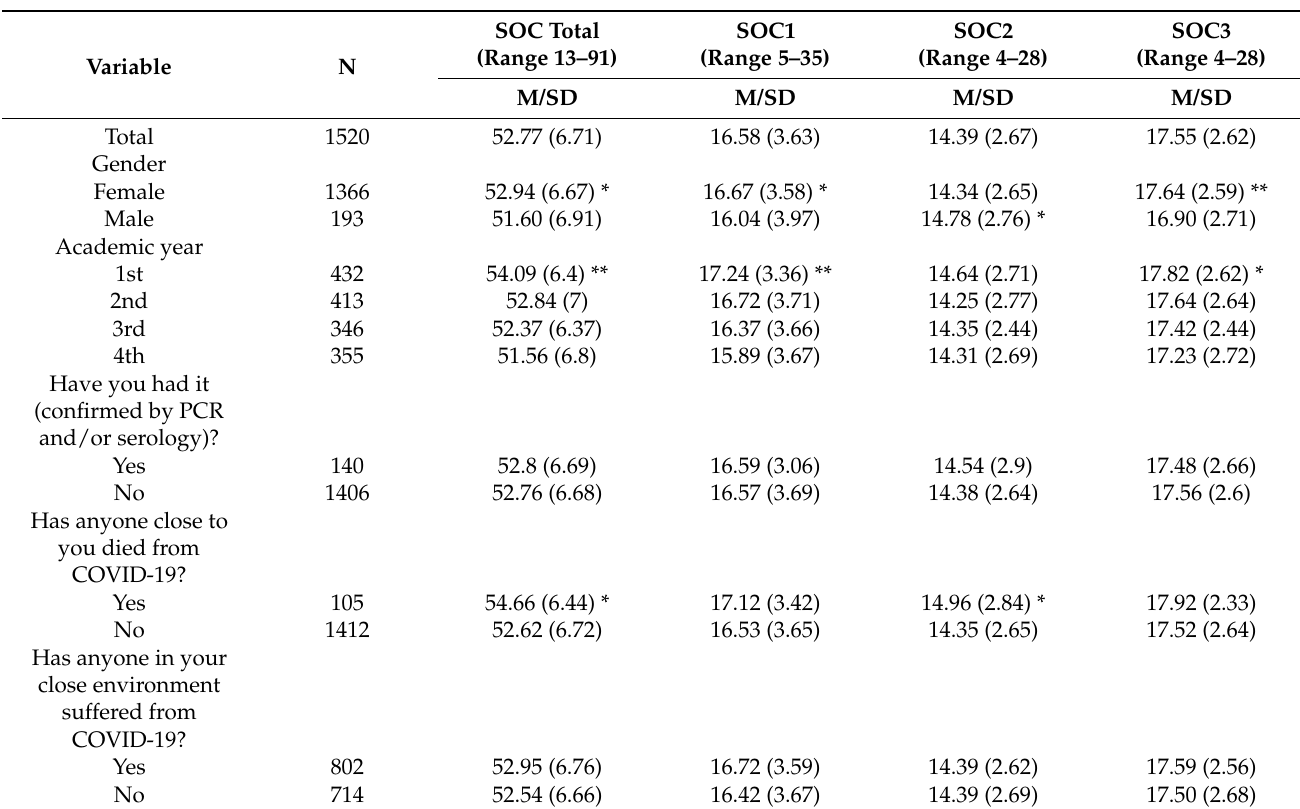
Table 4. Sense of coherence (SOC) versus COVID-19.